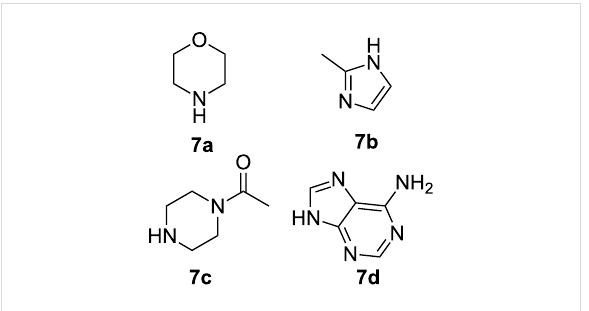
Figure 1: Amine-based nucleophiles used in the epoxide ring opening